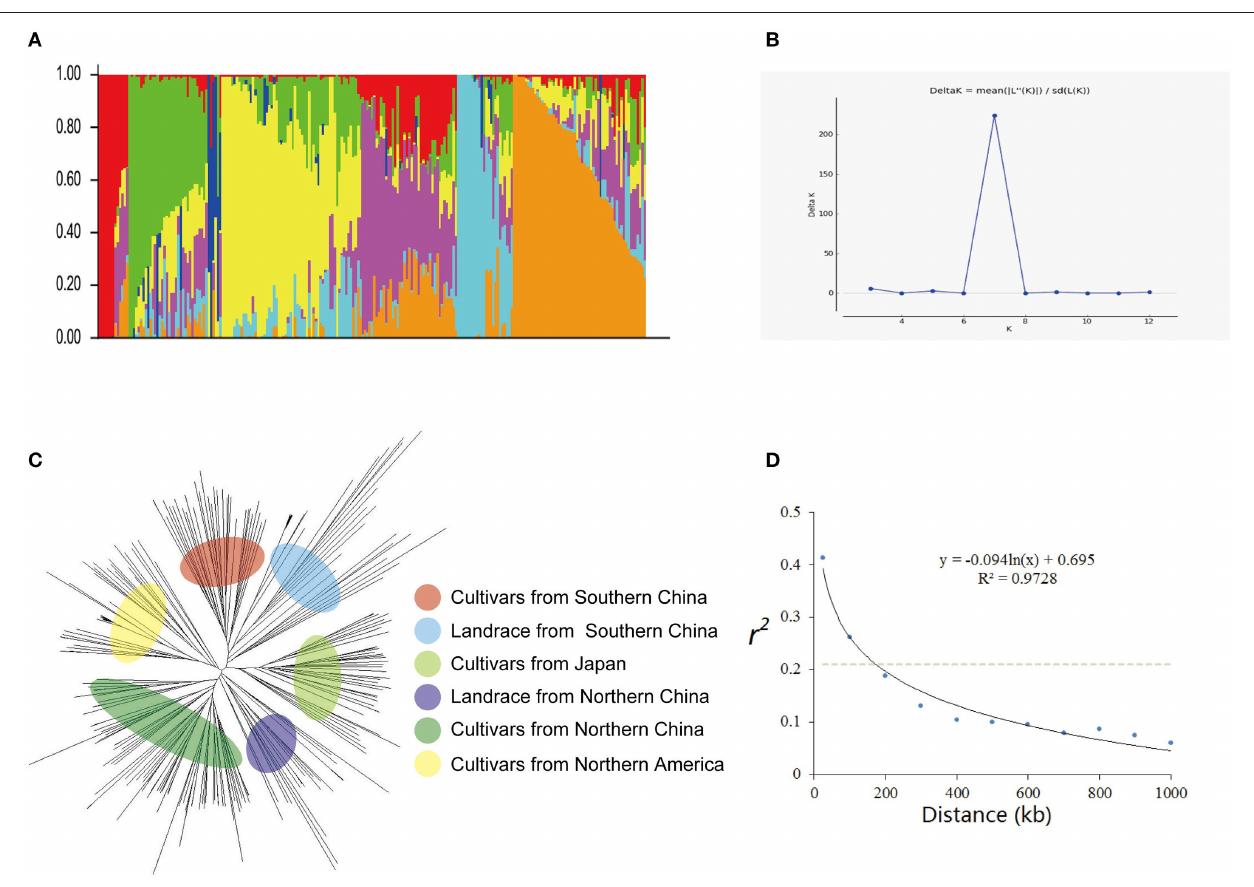
FIGURE 1 | Genetic diversity and population structure of 235 soybean cultivars or accessions. (A) Population structure of 235 cultivars at K = 7. Each cultivar is represented by a single vertical line and color represents one cluster. (B) Estimated Delta K(probability of the data) calculated for K ranging from 2 to 12. (C) Phylogenetic tree constructed using neighbor-joining method. (D) Average linkage disequilibrium (LD) decay rate in the soybean genome. The mean LD decay rate was estimated as squared correlation coefficient ( r 2 ) using all pairs of SNPs located within 1Mb of physical distance in a population of 235 soybean germplasm accessions. The dashed line in gray indicates the position where r 2 dropped to half of its maximum value.